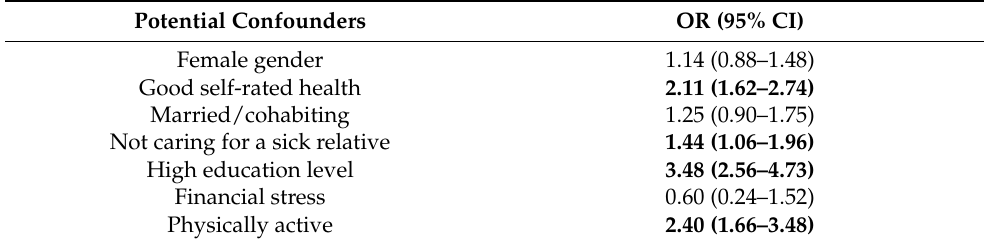
Table 3. Associations between potential confounders, measured at baseline, and high social partici- pation at the 10-year follow up.